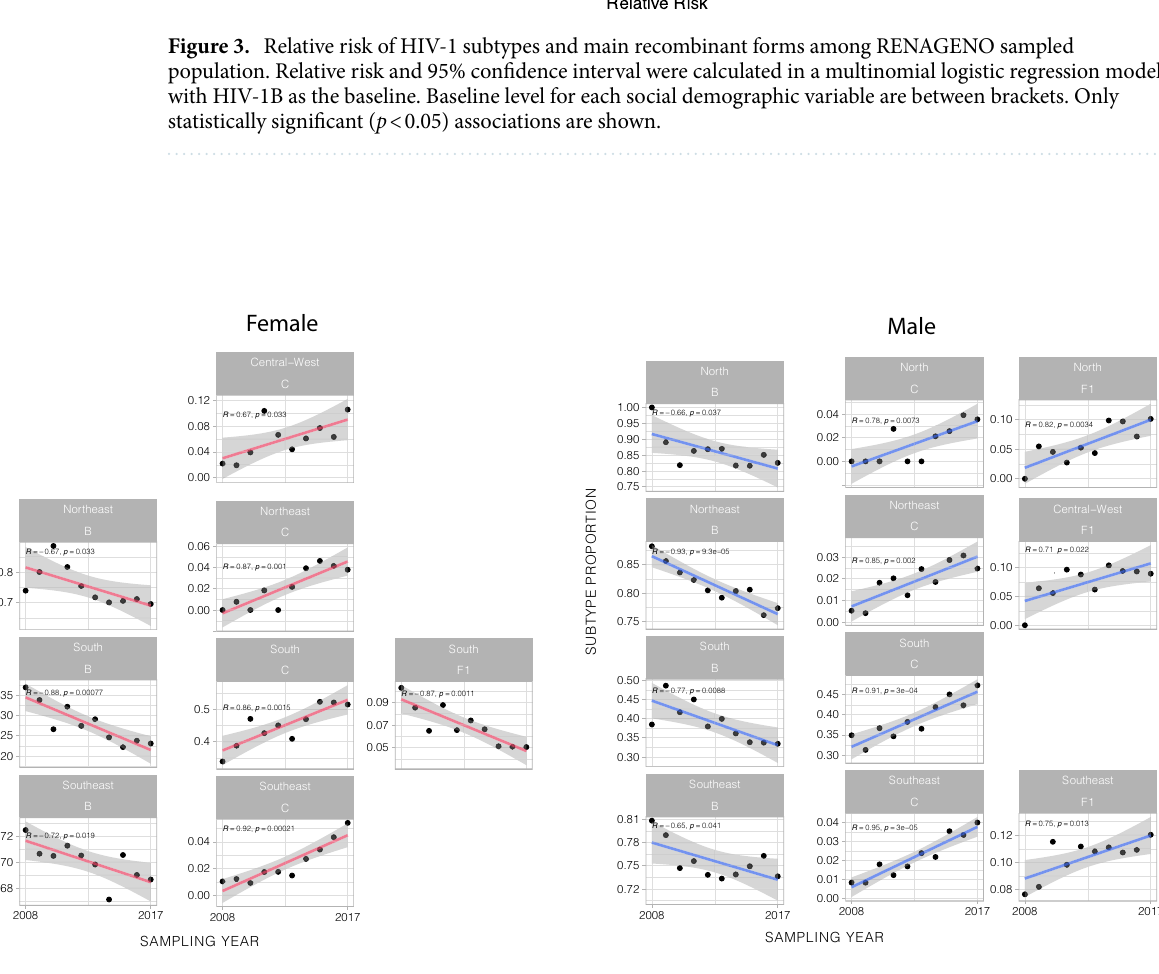
Figure 4. Temporal trends in HIV-1 subtypes proportions in Brazil. Pearson correlation plots between subtype proportion and sampling year (2008–2017) are shown for HIV-1B, C and F1 per Brazilian region. Only statistically significant ( p < 0.05) correlations are presented. The analysis was performed separately for women (left) and men (right). For the temporal trend of HIV-1 recombinant strains, see Supplementary Figure